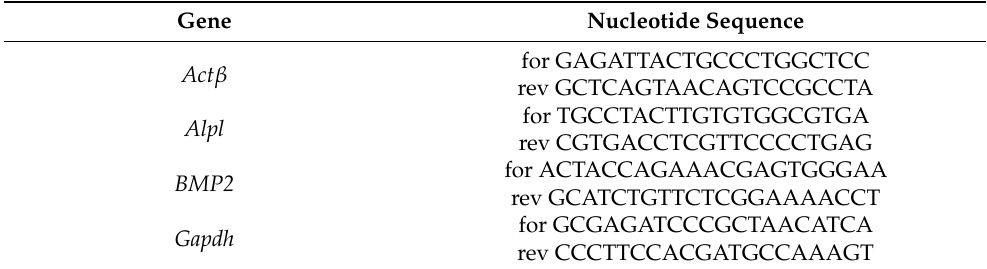
Table 1. Primers for